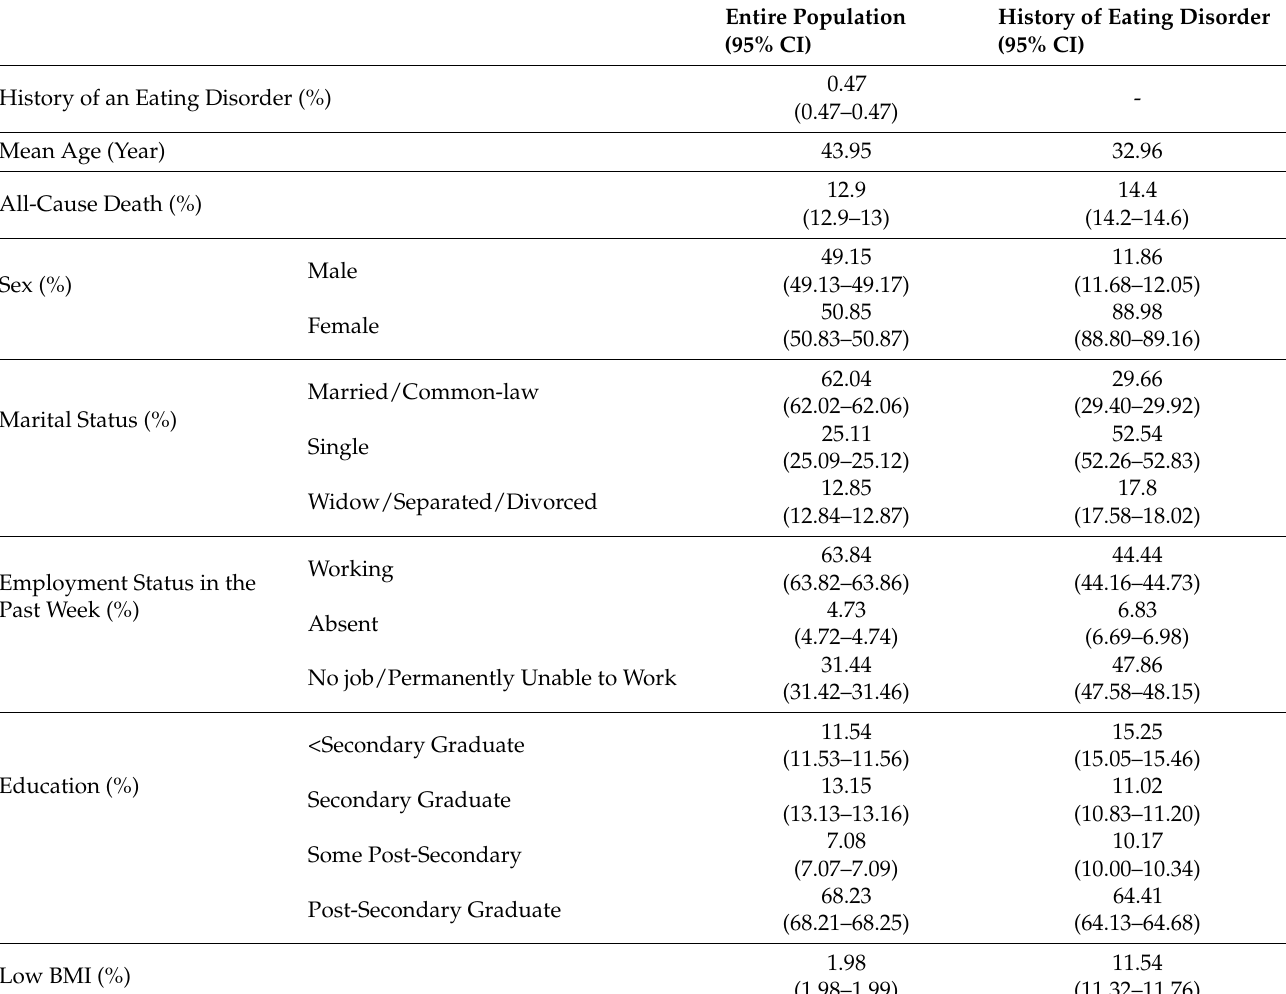
Table 1. Characteristics of the population † .